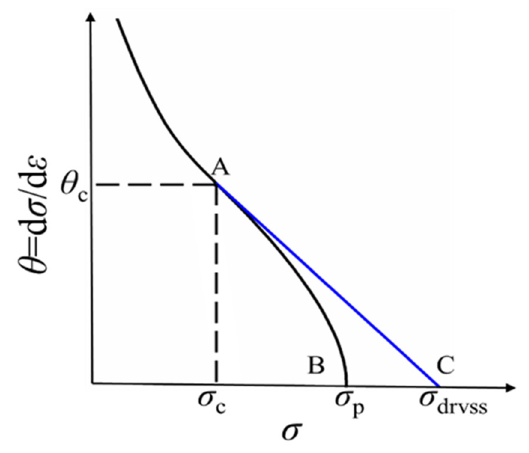
Figure 8. Plot of θ − σ curve employed to determine σ drvss by the intercept with the horizontal axis. The point A represents the critical point for the initiation of DRX; point B represents the point of peak stress; and point C represents the point of steady state stress in the ideal DRV-type stress–strain curves.